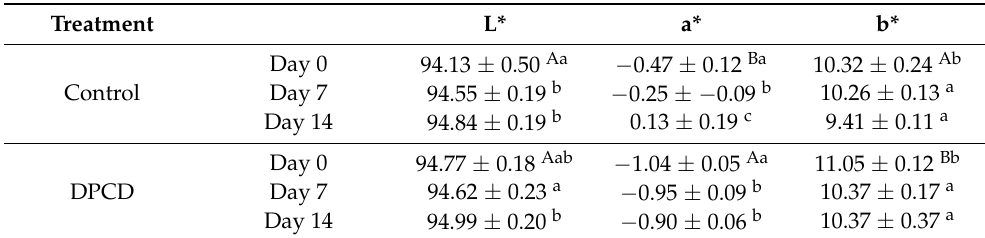
Table 4. Color parameters including L*, a* and b* of control and dense-phase carbon dioxide (DPCD)- processed cheese stored at 4 ◦